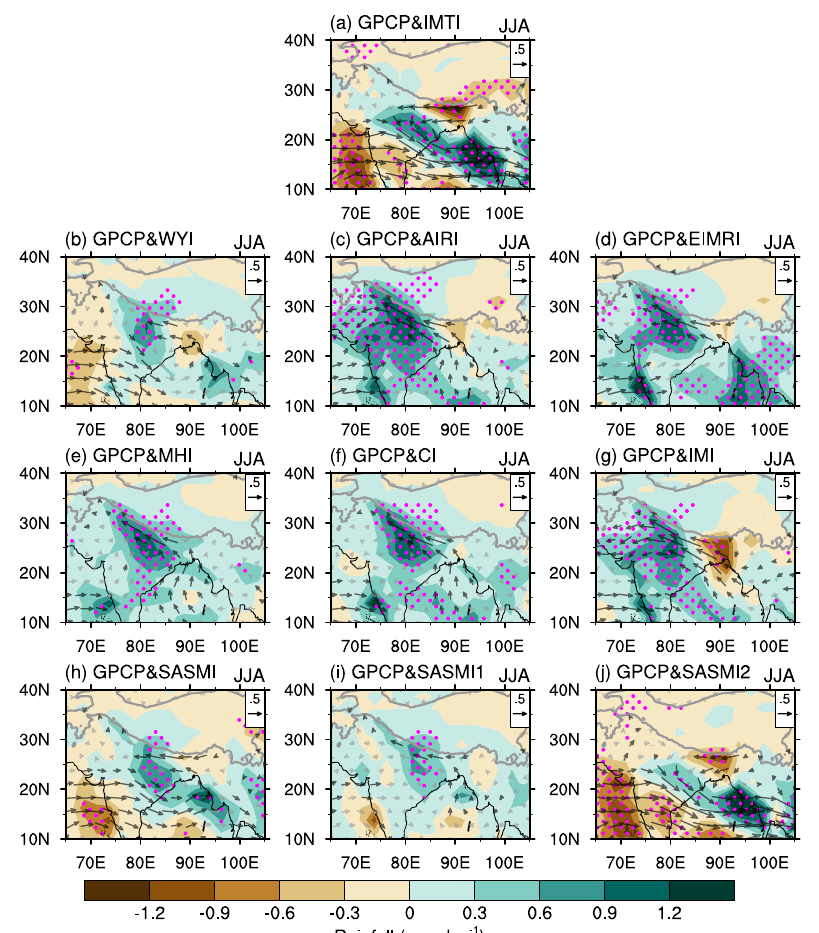
Fig. 4 | Spatial patterns of 850-hPa wind and rainfall associated with South Asiansummer monsoonindices. Regressions of 850-hPa wind (ms − 1 ; vector) and rainfall (mmday − 1 ; shading) against the a Indian monsoon trough index (IMTI), b Webster-Yang index (WYI), c All India Rainfall index (AIRI), d extended Indian monsoon rainfall index (EIMR), e monsoon Hadley circulation index (MHI),